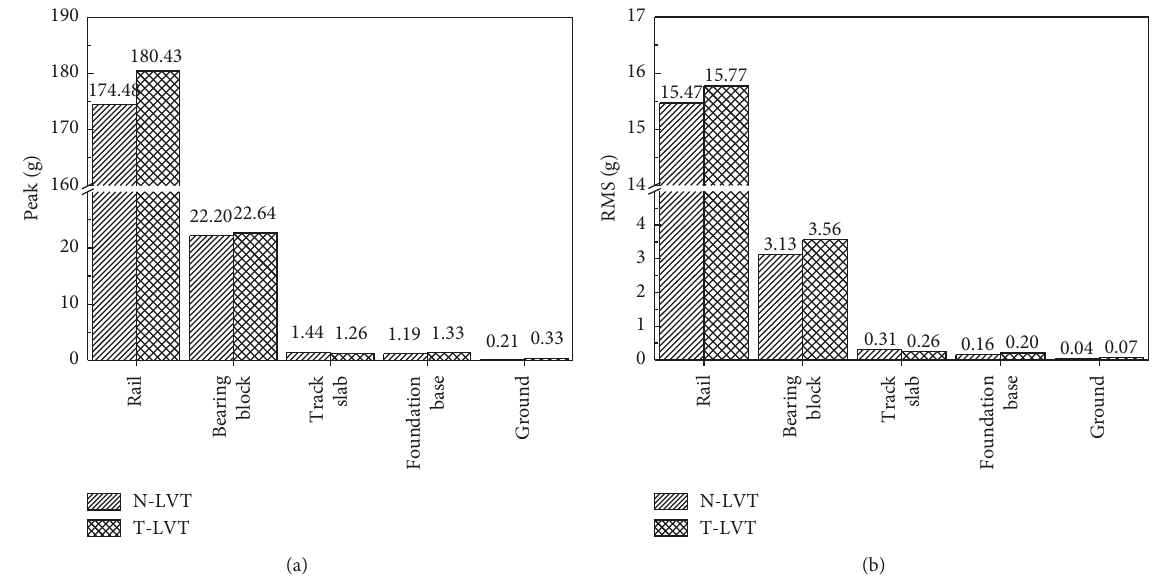
Figure 13: Track components acceleration peak and RMS. (a) Acceleration peak. (b) Acceleration RMS.